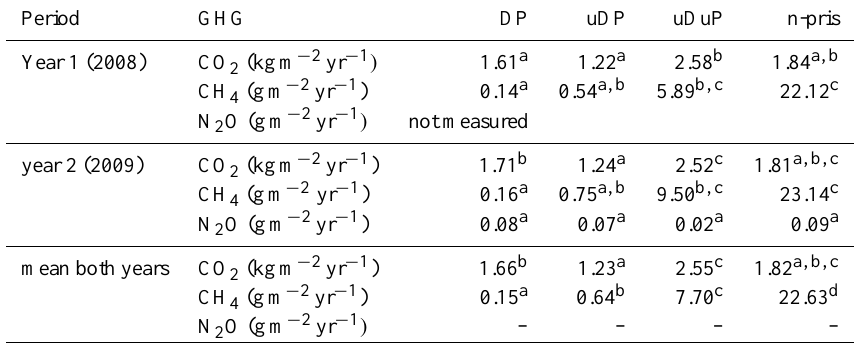
Table 3. Annual cumulative fluxes calculated for each treatment at Flanders Moss over the duration of the experiment in 2008 and 2009. Different letters across the different treatments indicate significant differences ( p <